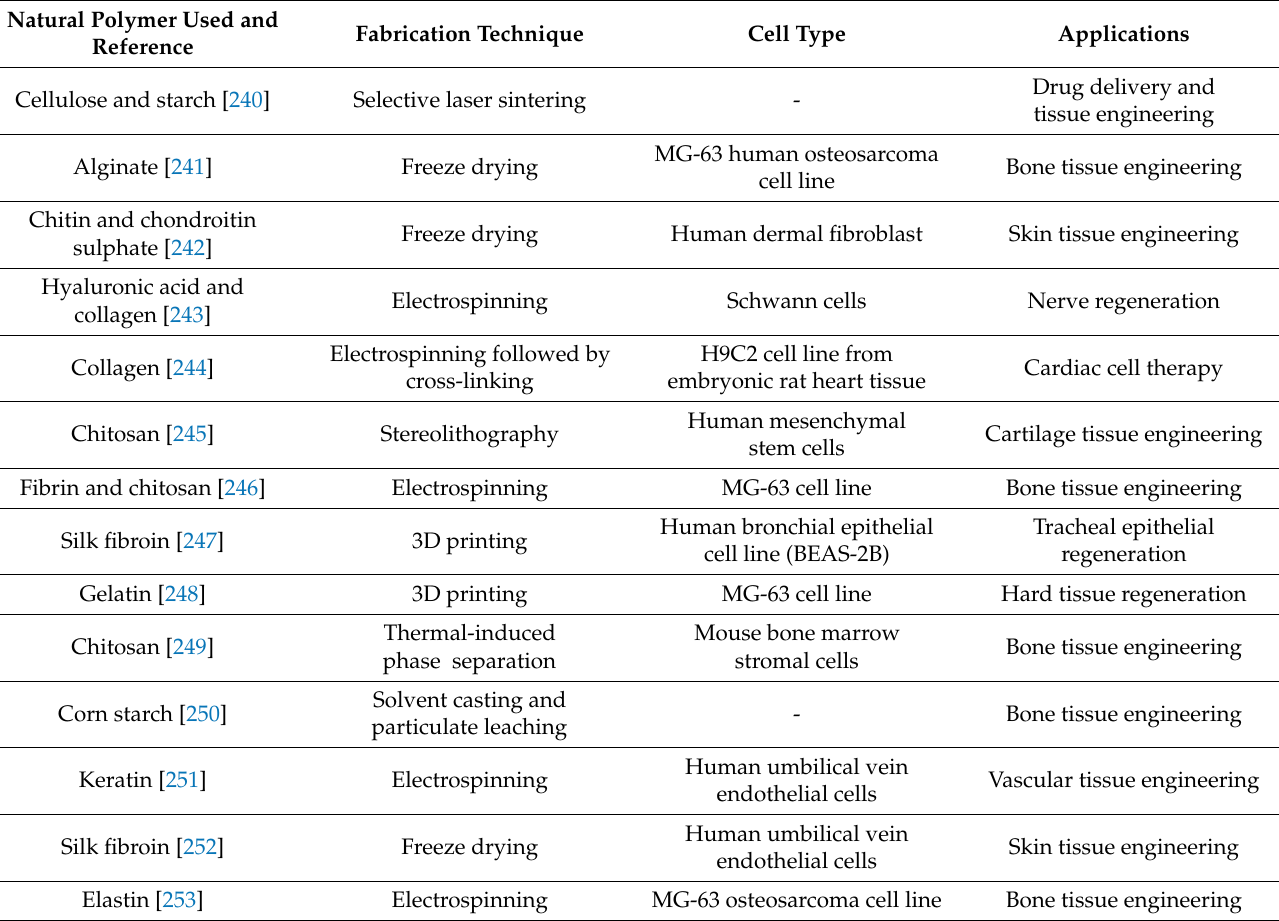
Table 6. Natural polymers used to fabricate scaffolds for various tissue regeneration